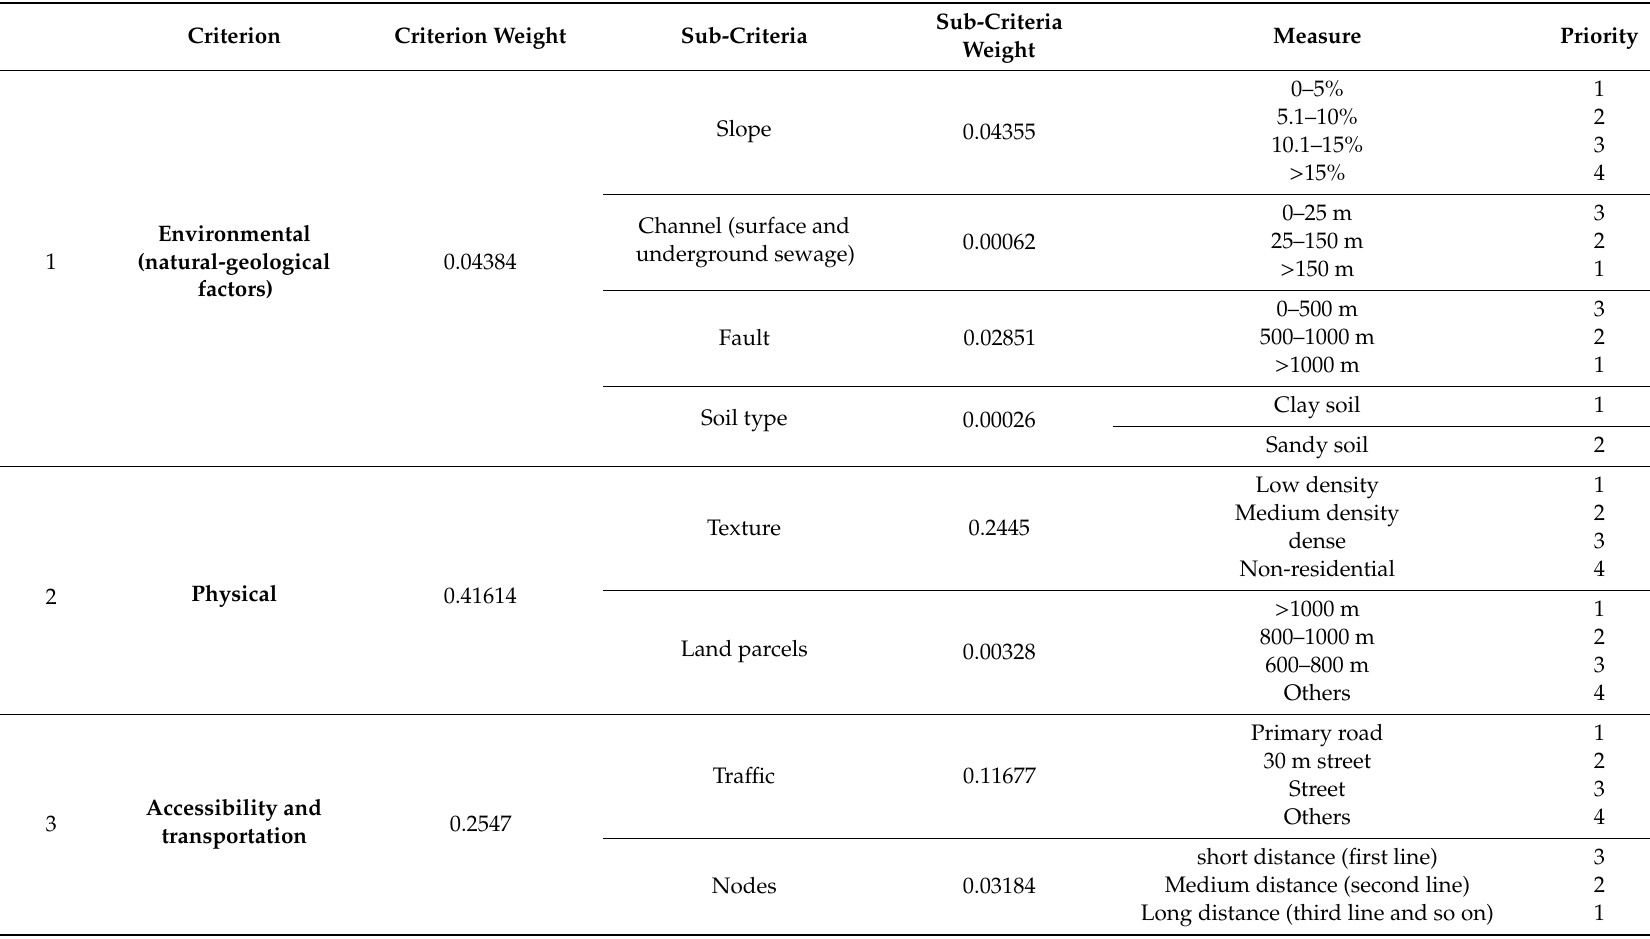
Table 1. The criteria and sub-criteria for locating tall buildings and their weights based on expert opinion, formulated using the ANP method and Super Decisions V2.8